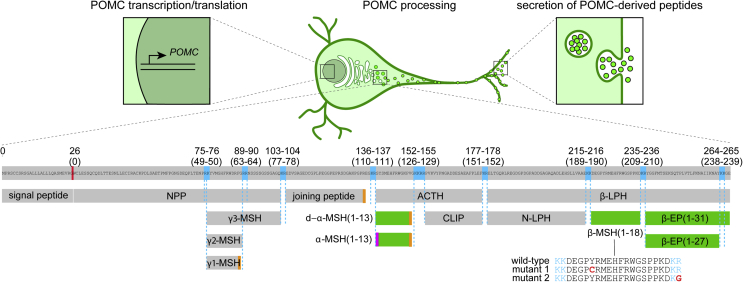
Regulation of POMC processing and secretion. Human POMC is translated as a 267-amino acid protein that, after removal of the signal peptide, undergoes successive rounds of cleavage and trimming at dibasic residues (blue) in a tissue-specific manner; the hypothalamic pattern is illustrated. Additional levels of post-translational modification include C-terminal amidation (orange) and N-terminal acetylation (magenta). The most extensively characterised POMC-derived peptides that regulate food intake (green) include d-α-MSH(1-13), α-MSH(1-13), β-MSH(1-18), β-EP (1-31) and β-EP (1-27). Illustrated mutations in β-MSH have been associated with obesity, suggesting a role for this peptide in human body weight regulation. The concentrations of secreted POMC-derived peptides may be regulated at the levels of transcription, translation, processing, and secretion. ACTH, adrenocorticotropic hormone; CLIP, corticotropin-like intermediary peptide; EP, endorphin; LPH, lipotropin; MSH, melanocyte stimulating hormone; NPP, POMC N-terminal region; POMC, pro-opiomelanocortin.